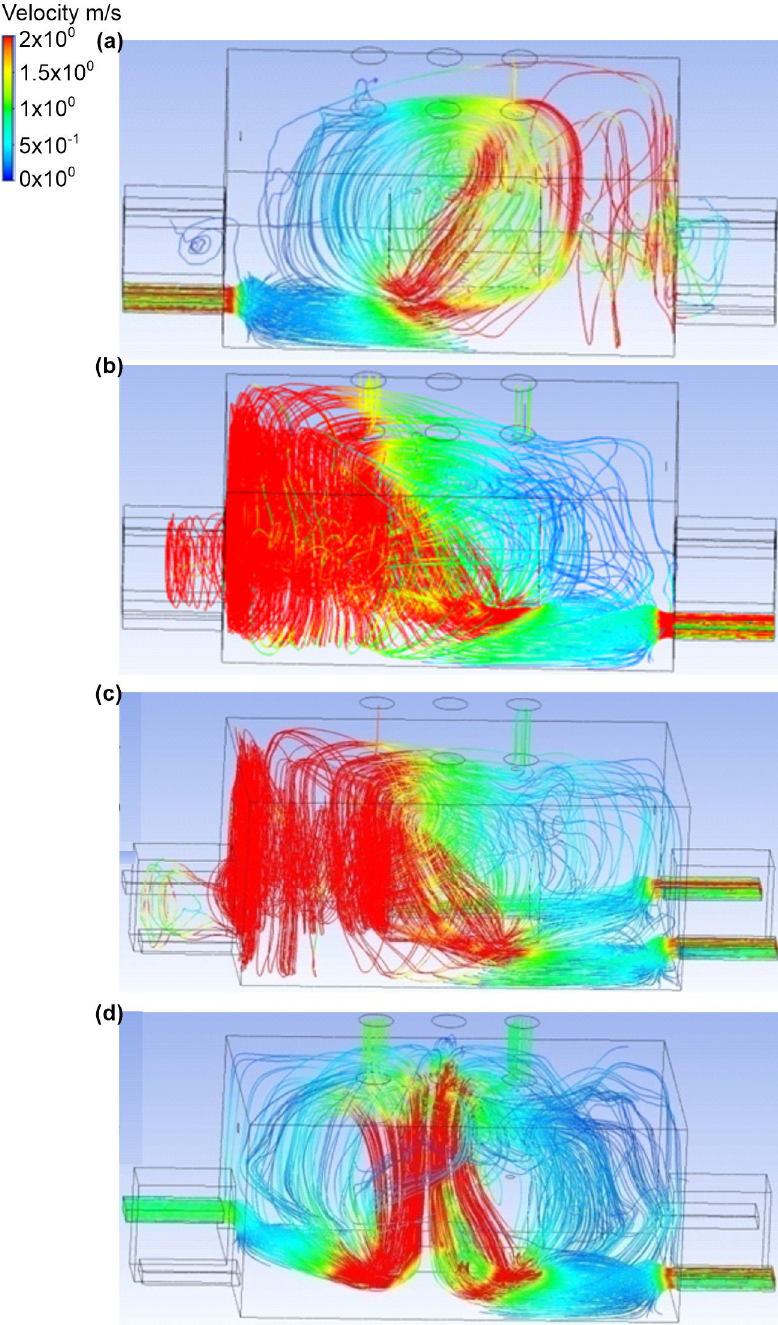
Figure 15. Velocity distribution in the engine room for: ( a ) scenario A, ( b ) scenario B, ( c ) scenario C, and ( d ) scenario D.